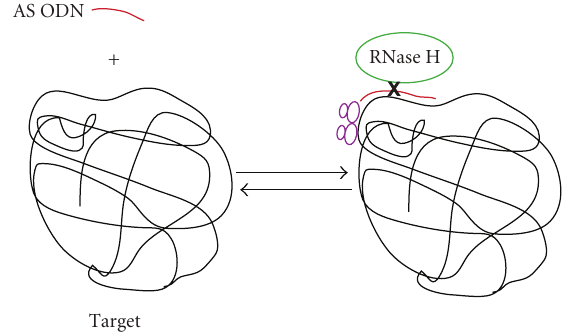
Figure 1: Antisense mechanism. A schematic representation is shown for two dominant mechanisms by which AS ODN molecules delivered into cells can suppress gene expression. The AS ODN must first anneal to an accessible region of the target mRNA. The first and likely dominant mechanism of inhibition is through recruitment of RNaseH (green) to cleave the RNA is the center of the ODN: Target RNA hybrid region. The second mechanism involves physical hindrance of biochemical processes operative on the mRNA such as ribosome- (violet-) mediated translation, 5 (cid:3) decapping, and 3 (cid:3) deadenylation. Here, the hybridized ODN is depicted blocking the progress of translating ribosomes on the